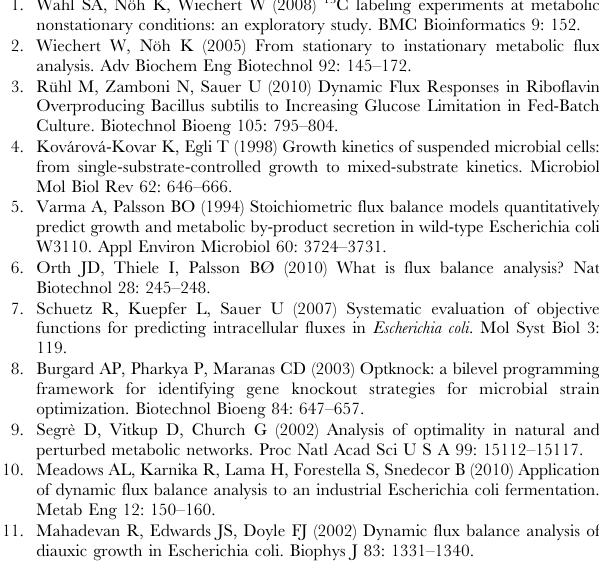
Figure S2 Flux ratio of malate synthase (MALS) and fumarase (FUM) in dynamic metabolism of Shewanella oneidensis MR-1. Blue & : time profiles of flux ratio using ‘‘maximizing growth rate’’ as the objective function in dFBA; red m : time profiles of flux ratio